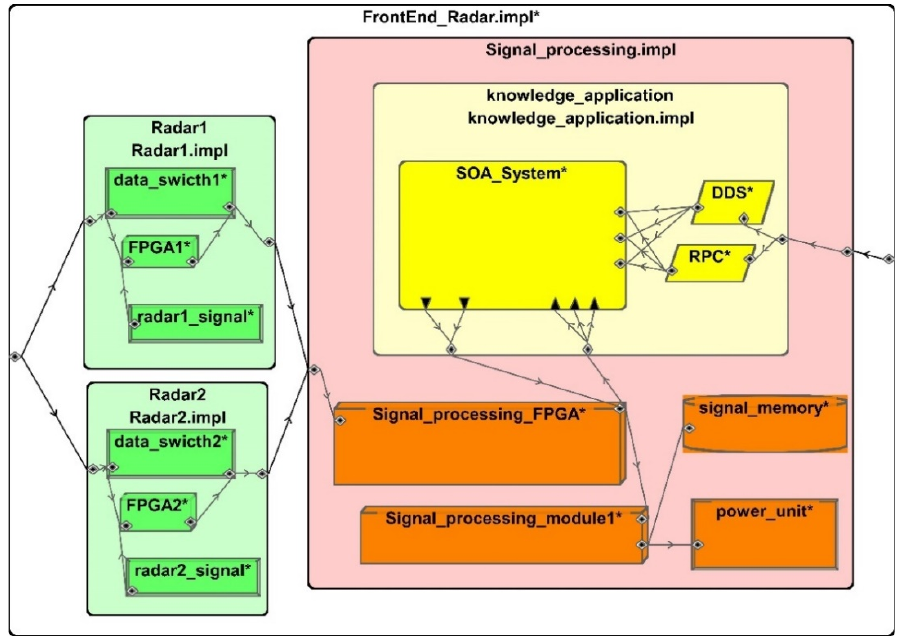
Figure 6. AADL model of avionics three ‐ level architecture.